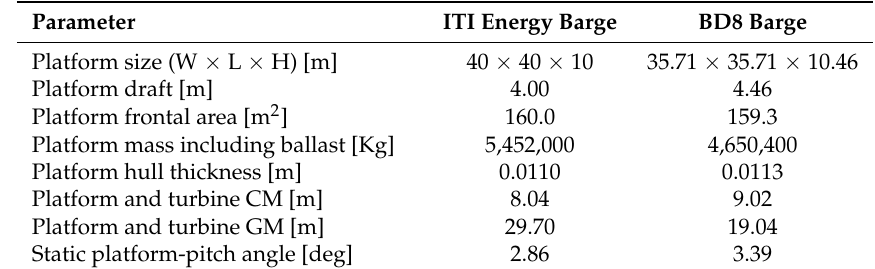
Table 1. ITI Energy and BD8 barges’ properties.